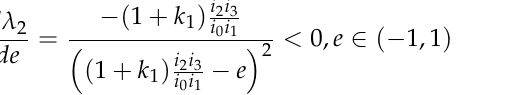
Figure 12. HMCVT hardware in the loop test platform.